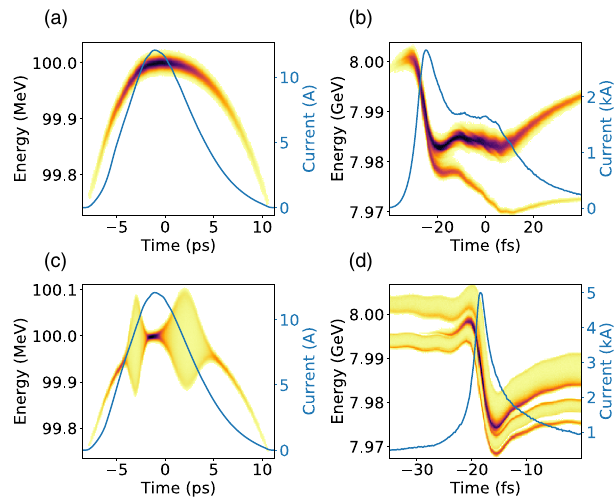
FIG. 2. Longitudinal phase space after the laser heater (a, c) and right before the hard x-ray undulator line (b, d) for the seed (a, b) and shaped (c, d)